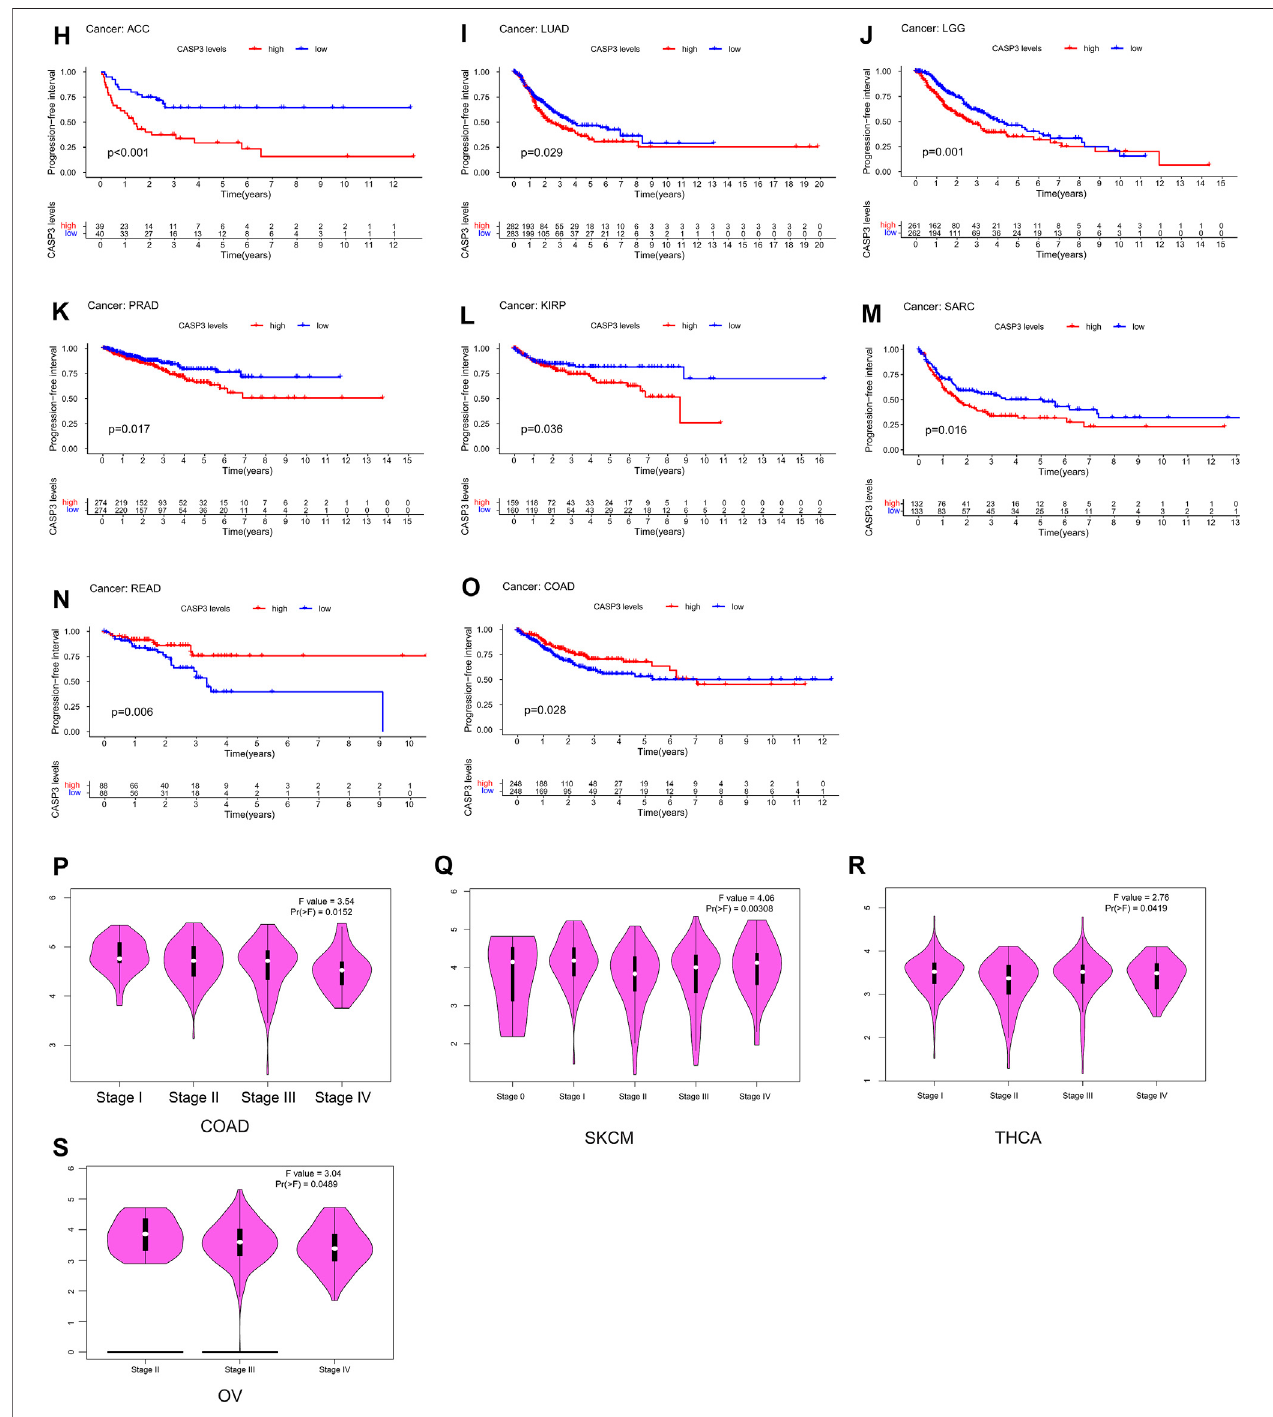
( p < 0.001), STAD ( p < 0.001), and KIRC ( p = 0.019), CASP3 expression was positively correlated with MSI, but was negatively correlated with MSI in DLBC ( p = 0.008) and LUAD ( p = 0.03, Figure 7B